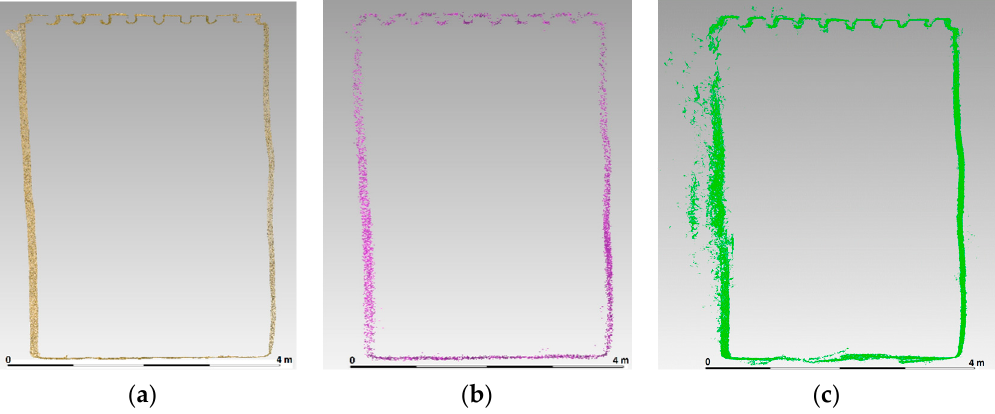
Figure 22. Comparison of the cross-section from ( a ) BLK360, ( b ) Zeb-REVO, and ( c ) close-range photogrammetry (iPhone camera). At the top: A ceiling made of beams and reeds.